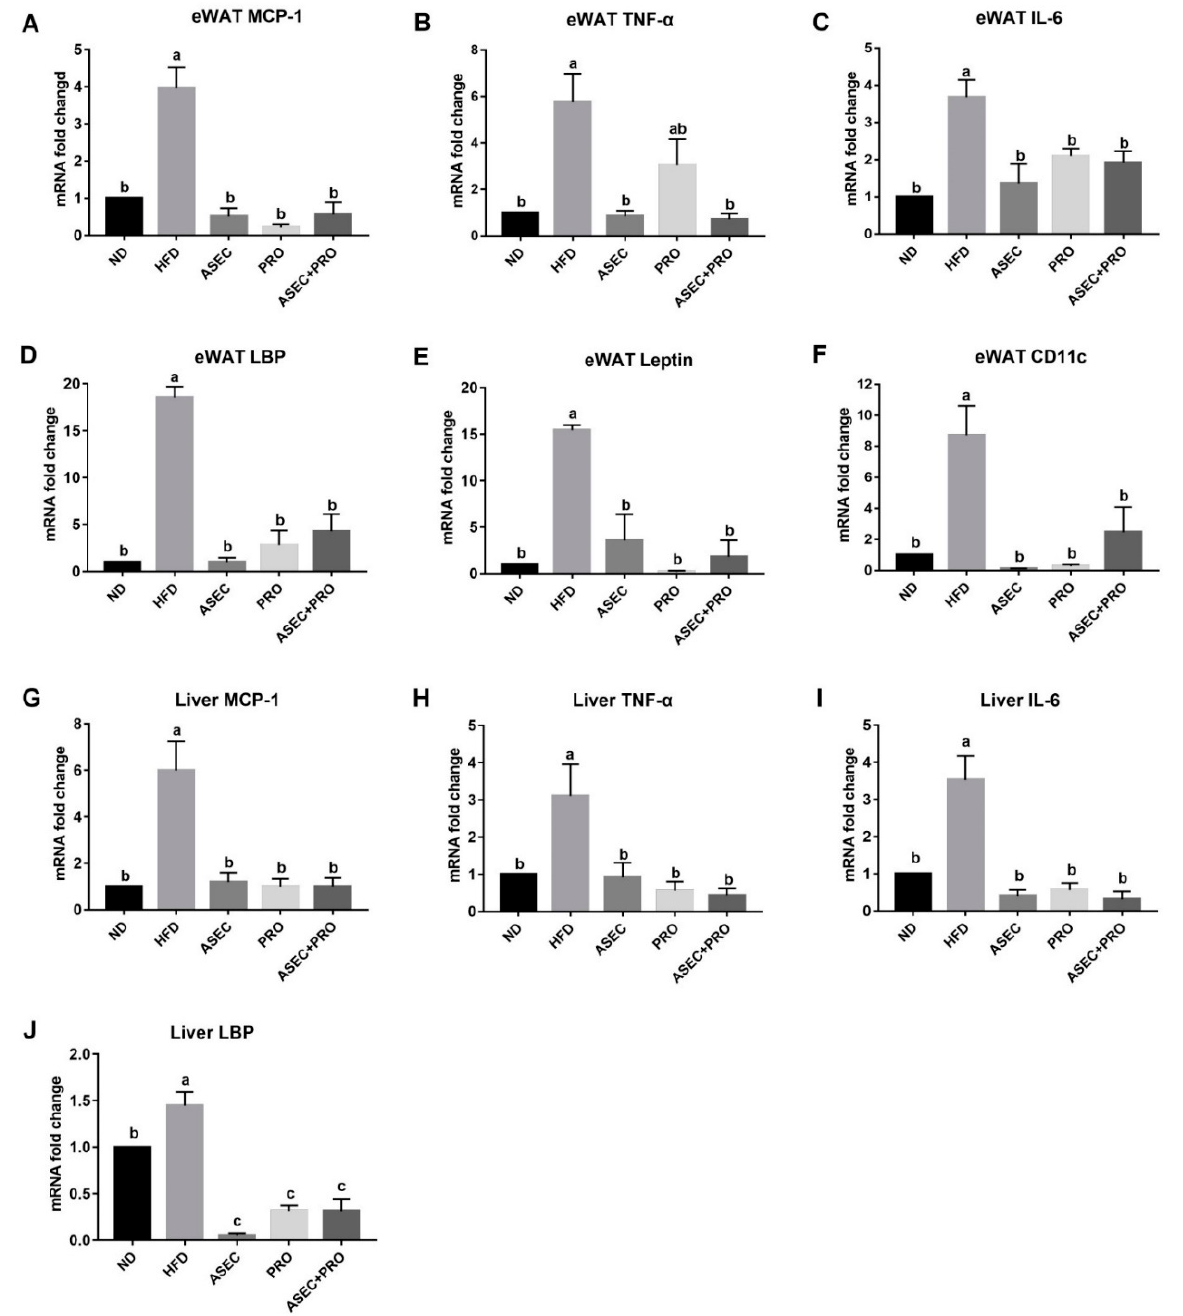
Figure 4. Intervention with ASEC, PRO, or ASEC + PRO reduced the transcription level of inflammatory genes in the liver and adipose tissues in HFD-induced obese mice. ( A – F ) The mRNA expression levels of MCP-1 ( A ), TNF- α ( B ), IL-6 ( C ), LBP ( D ), leptin ( E ), and CD11c ( F ) in the epididymal white adipose tissue (eWAT). ( G – J ) The mRNA expression levels of MCP-1 ( G ), TNF- α ( H ), IL-6 ( I ), and LBP ( J ) in the liver. Quantitative real-time PCR (qPCR) was performed. Data ( n = 8) are expressed as the mean ± SEM. MCP-1, monocyte chemoattractant protein-1; TNF- α , tumor necrosis factor- α ; IL-6, interleukin-6; LBP, lipopolysaccharide binding protein. Statistical significance ( p < 0.05) is indicated by different letters (e.g., a,